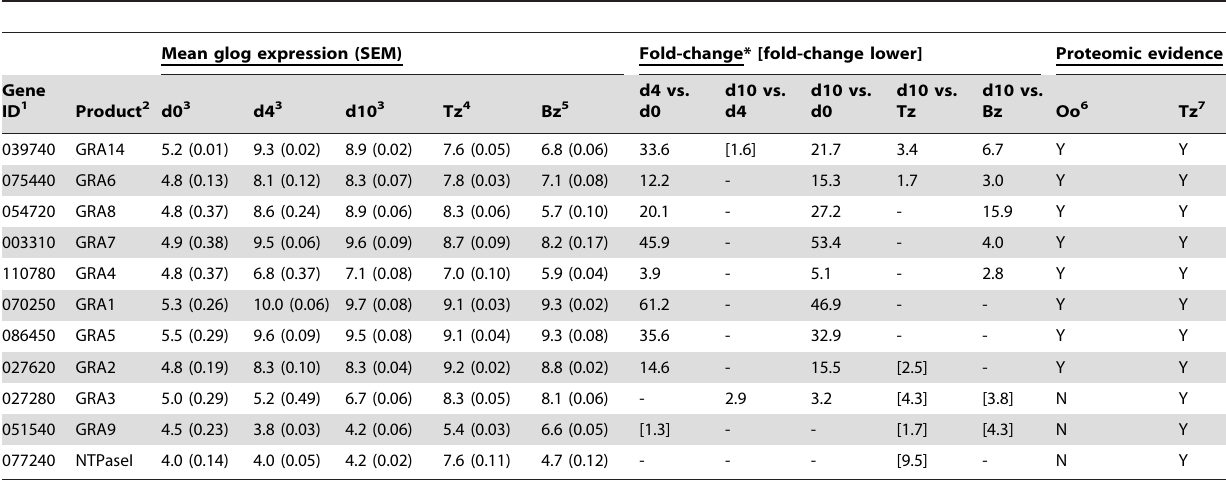
Table 7. Functionally interesting genes of Toxoplasma gondii at different stages of oocyst maturation with a comparison to bradyzoite and tachyzoite expression levels - dense granules.